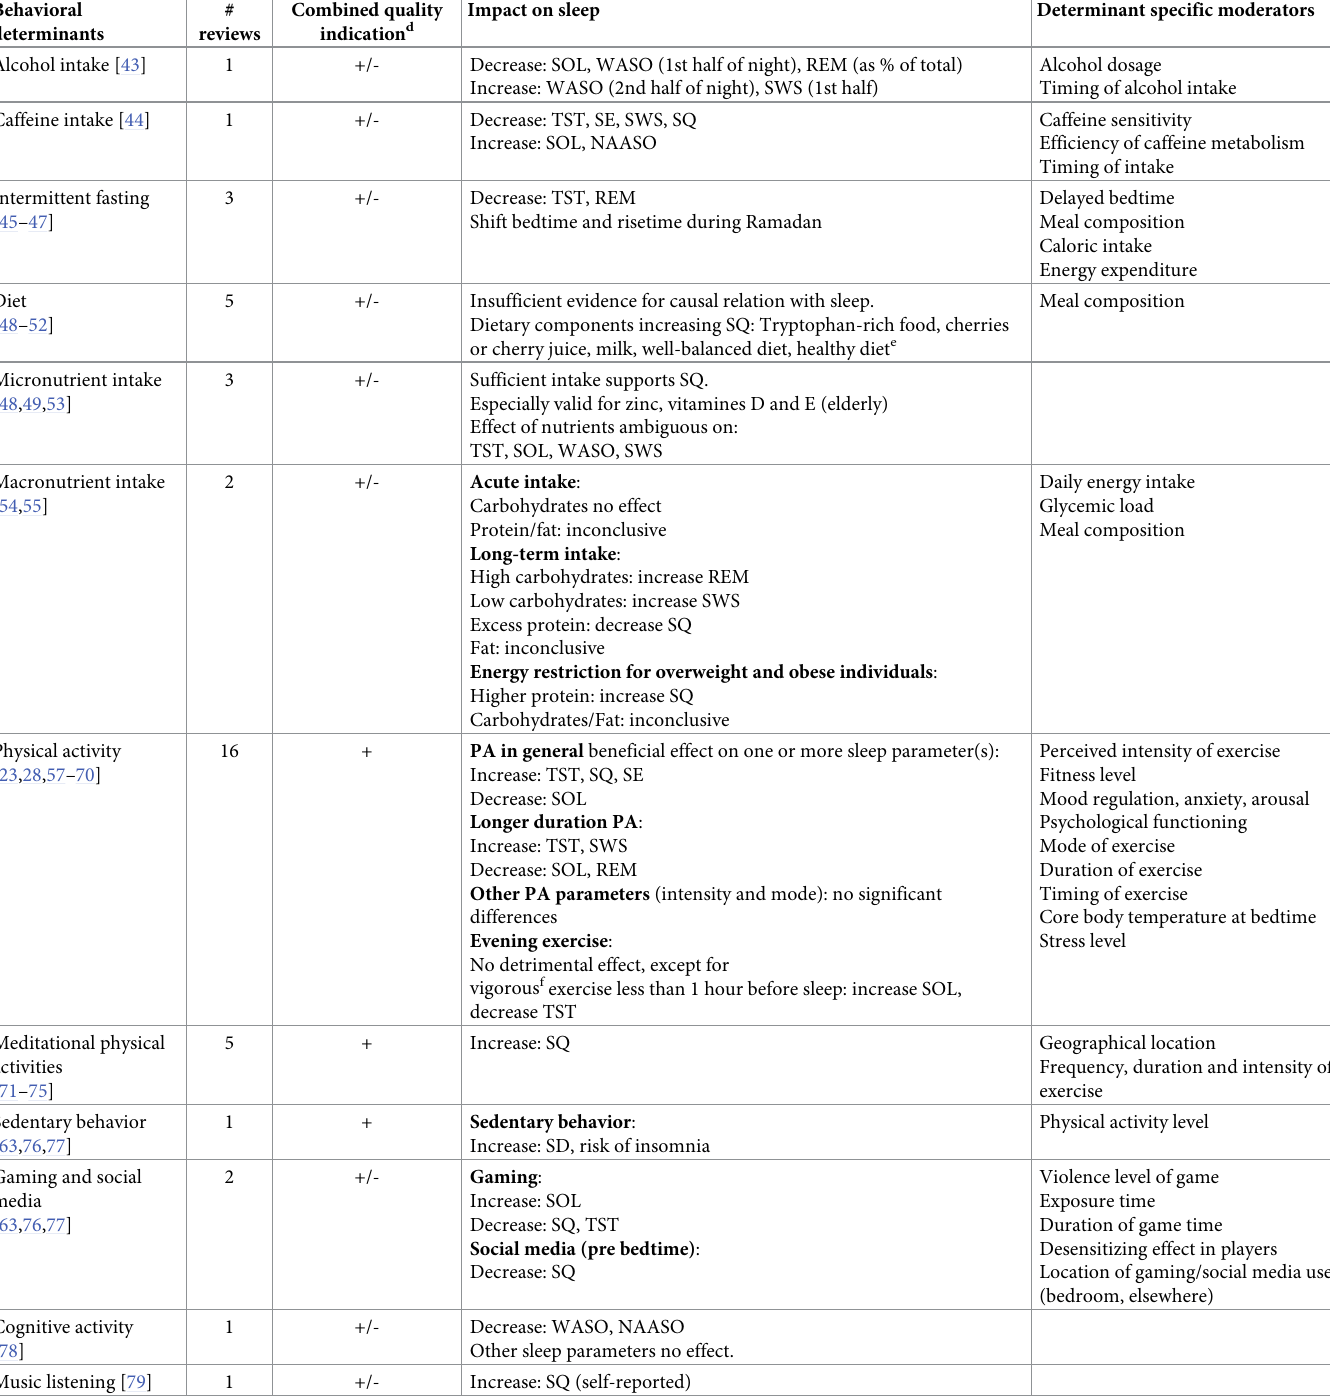
Table 4. Overview of behavioral determinants of